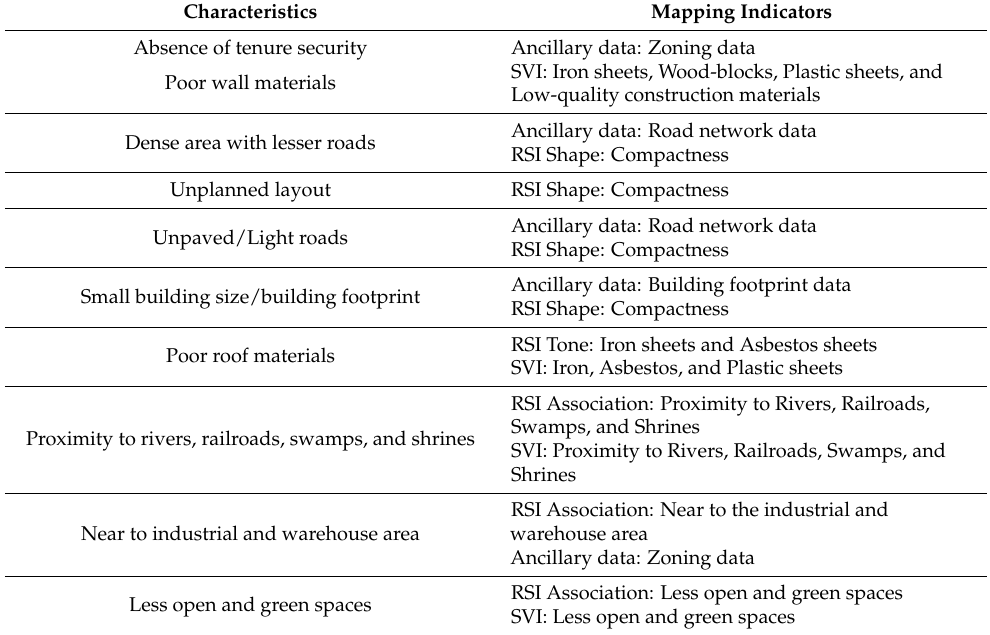
Table 1. Conversion of chosen characteristics of slums into mapping indicators 1 in order to modify the 2017 official reference map of slum Source: